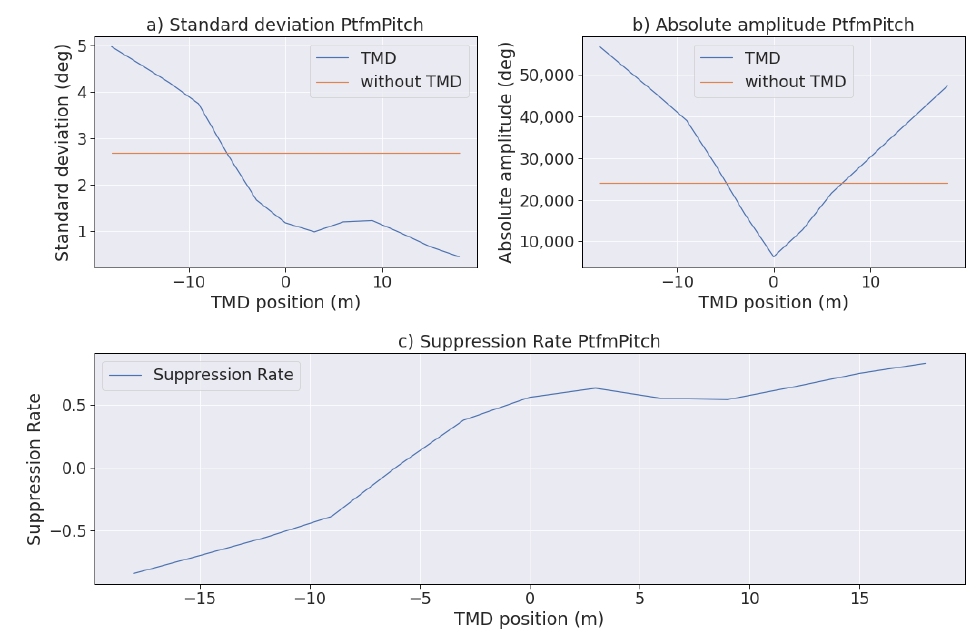
Figure 5. Platform pitch when moving the TMD on the platform in the fore-aft direction. ( a ) Sum of PTfmPitch standard deviation; ( b ) Sum of PTfmPitch amplitude; and, ( c ) PTfmPitch suppression rate.